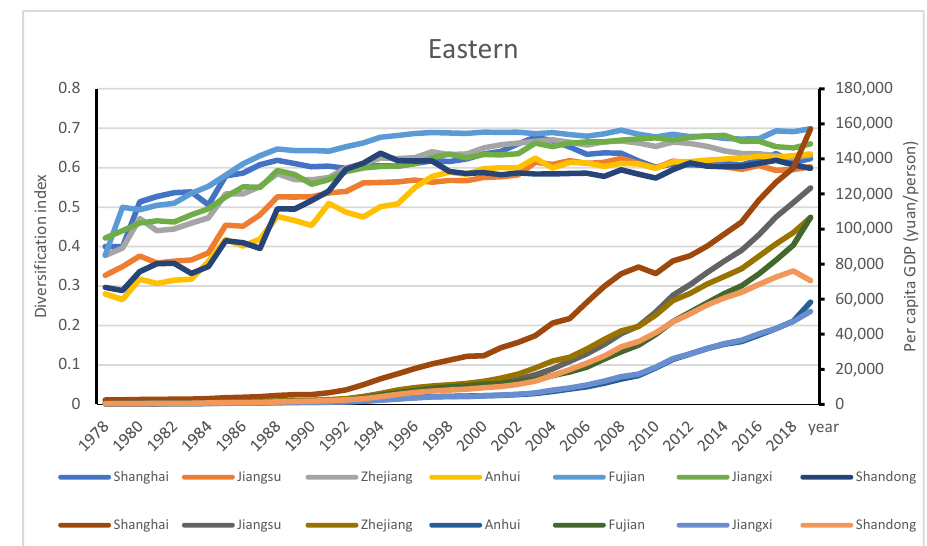
Figure 12. Geographic distribution of AD in the eastern region of China. The AD level of the northwest ranged from 0.34 in 1978 to 0.4303 in 2019; the turning point of 0.47 was reached in 2008 with per capita GDP of RMB 17422 /person (see Figure 11). Gansu, Qinghai and Xinjiang had reached the turning points of AD in 1988 to 1989. Shaanxi and Ningxia had reached their turning points of AD in 2003. In the northwest, the two provinces with lower AD indices of 0.39, Gansu and Xinjiang, deserve special attention. In 1988, Gansu reached its highest diversification level of 0.47 when its per capita GDP was RMB 898.13/person, and reached lowest AD (0.39) in the whole of China in 2019, where the farming sector was the main contributor of agricultural products. Farming’s agricultural contribution ranged from 80.4% in 1978 to 69.21% in 2019; forestry contributed 2.76% in 1978 to 2.02% in 2019; animal husbandry’s contribution ranged from 16.88% in 1978 to 20.96% in 2019; fishery ranged from 0.02% in 1985 to 0.11% in 2019. Xinjiang peaked its diversification index of 0.44 in 1989 when its per capita GDP was RMB 1494.43/person; its diversification level in 2019 was 0.41. In Xinjiang, farming’s agricultural contribution ranged from 74.53% in 1978 to 67.94% in 2019; forestry contributed 1.78% in 1978 to 1.7% in 2019;